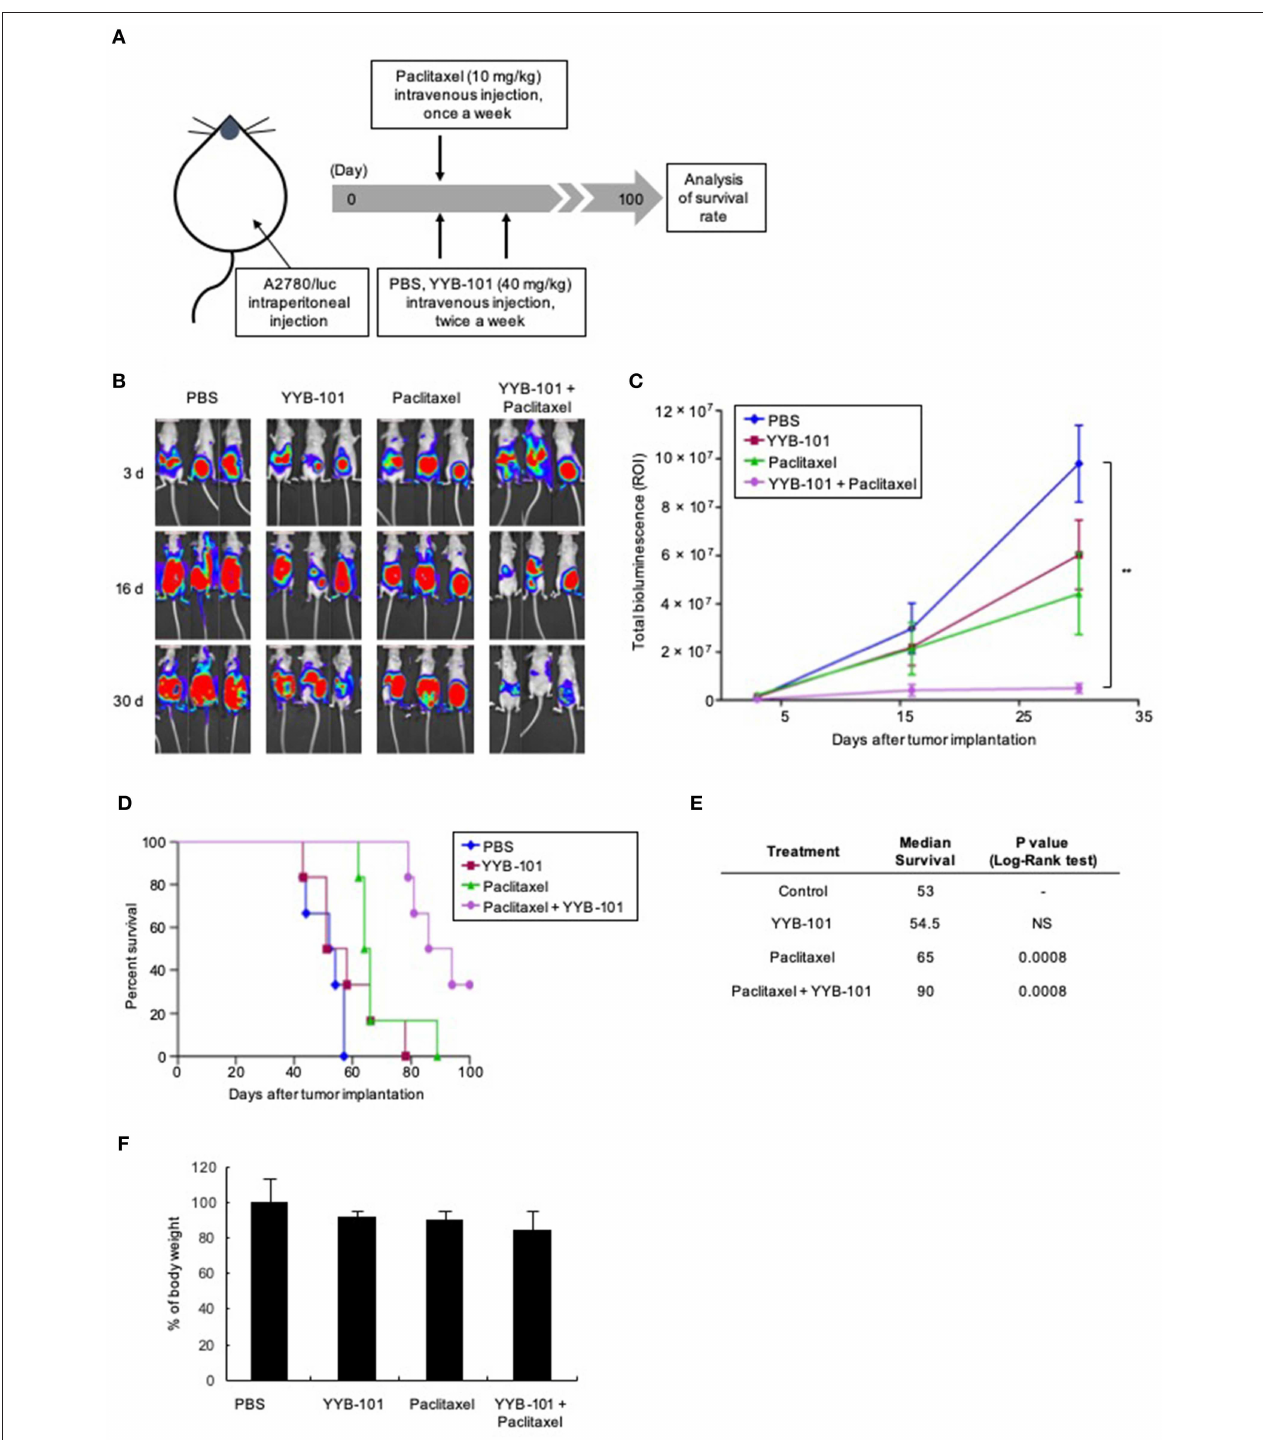
FIGURE 5 | Efficacy of YYB-101 in a mouse ovarian cancer xenograft model. A2780/luc cells (1 × 10 7 ) were intraperitoneally injected into mice, which were randomly divided into four groups ( n = 6 per group). Control mice were injected intravenously with phosphate-buffered saline (PBS). Where indicated, mice were injected with 40 mg/kg YYB-101 twice weekly and with 10 mg/kg paclitaxel once weekly. (A) Schematic of experimental design. (B) Monitoring of tumor progression using in vivo Imaging System (IVIS) bioluminescence imaging once weekly. Mice were injected intraperitoneally with 75 mg/kg luciferin and bioluminescence images were obtained using an IVIS imaging device. Representative images 3, 16, and 30 days after tumor implantation are shown. (C) Quantitation of total bioluminescence using Living